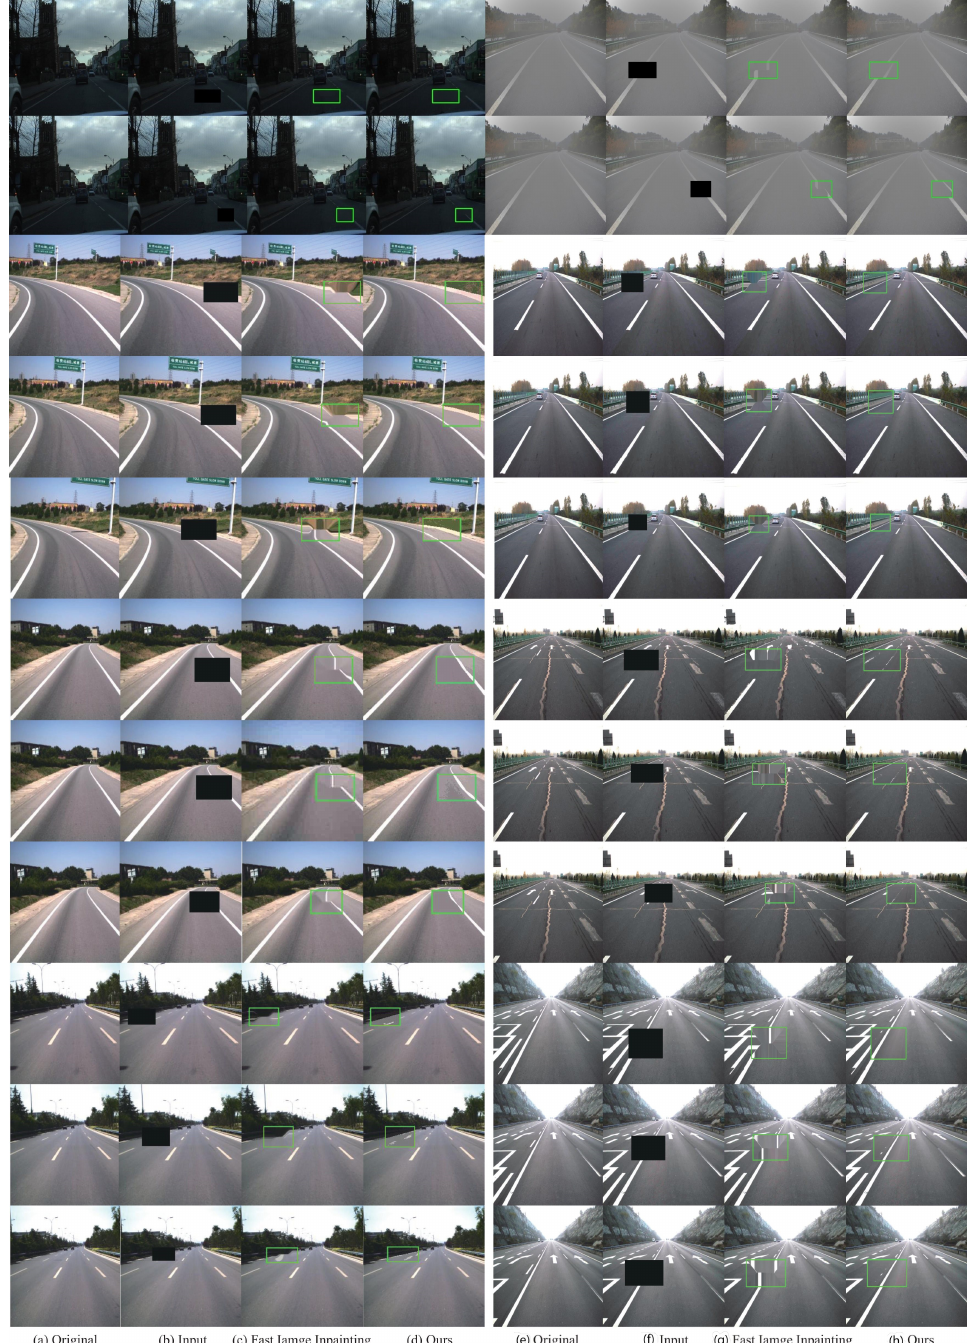
Figure 9. Quantitative results for image inpainting with black masks on